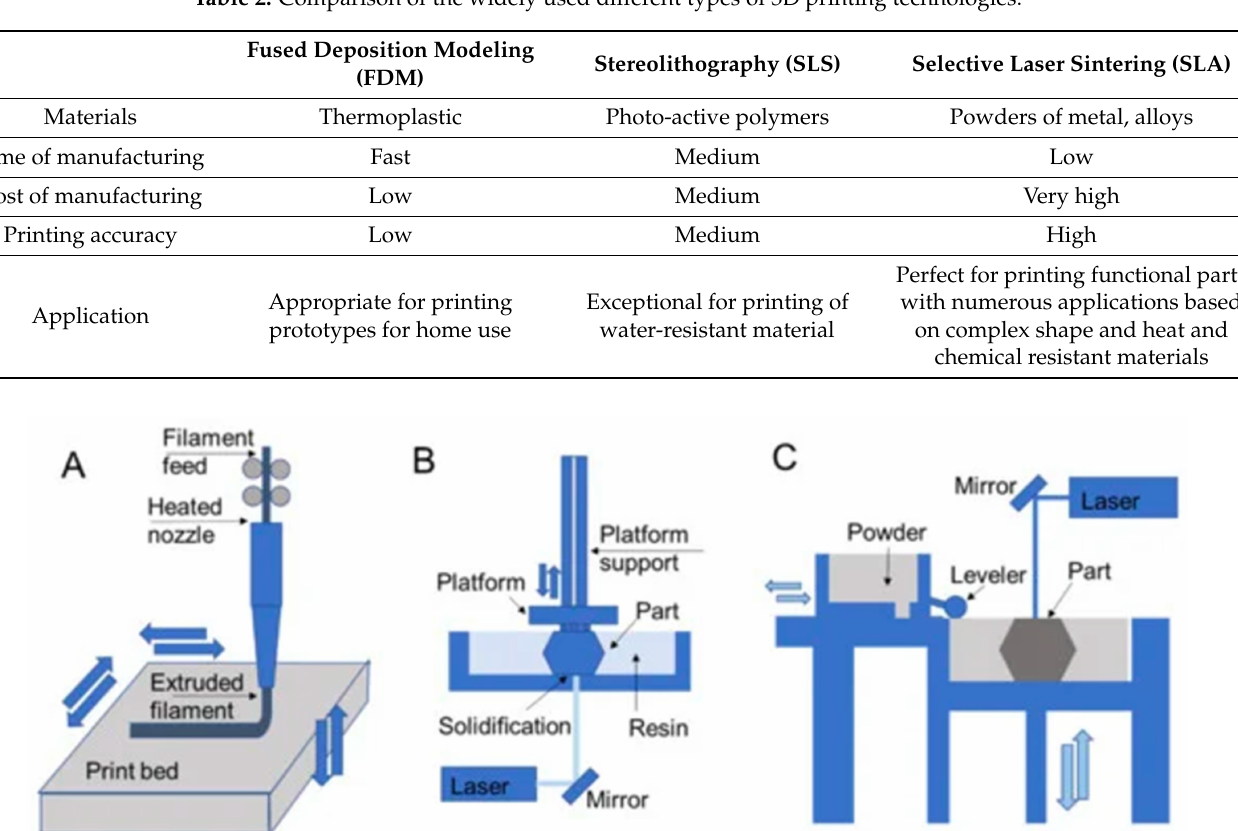
Table 2. Comparison of the widely used different types of 3D printing technologies.